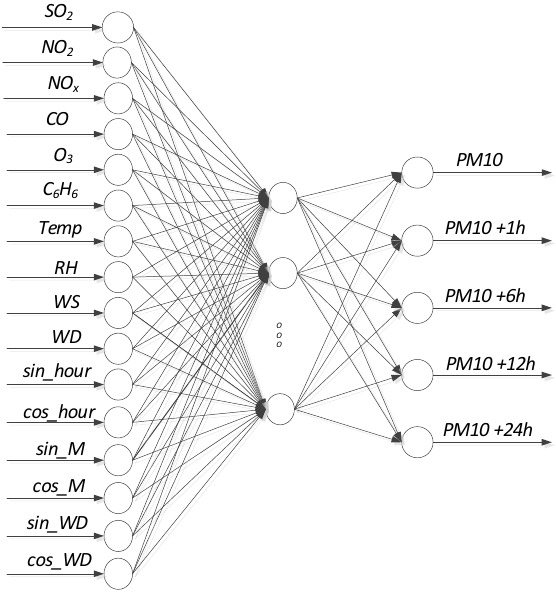
Figure 11. A schematic representation of an artificial neural network.